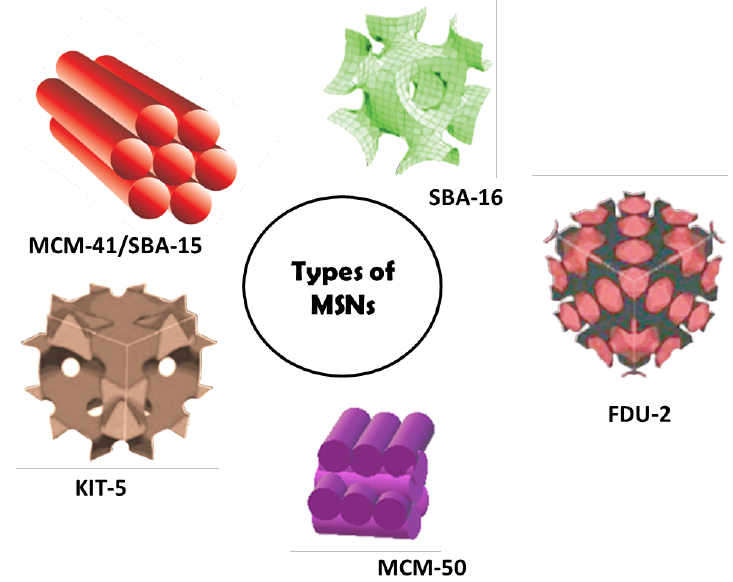
Figure 1. Representation of different types of mesoporous silica nanoparticles (MSNs).